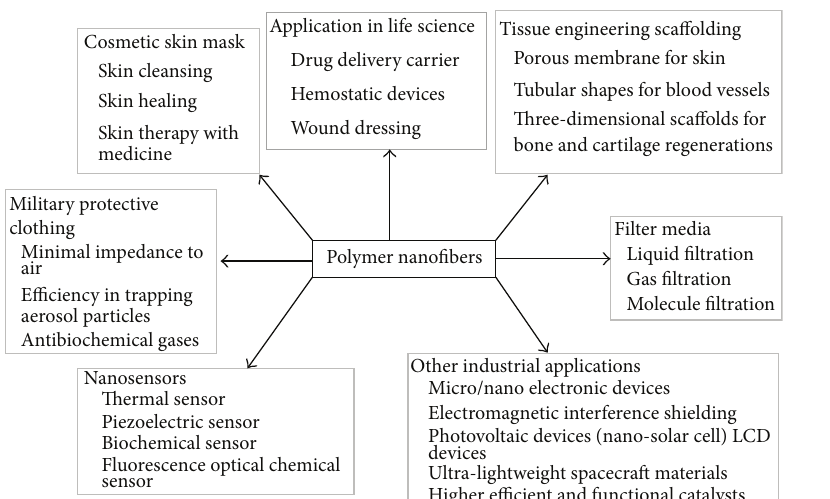
electrospun using polymer solution and polymer